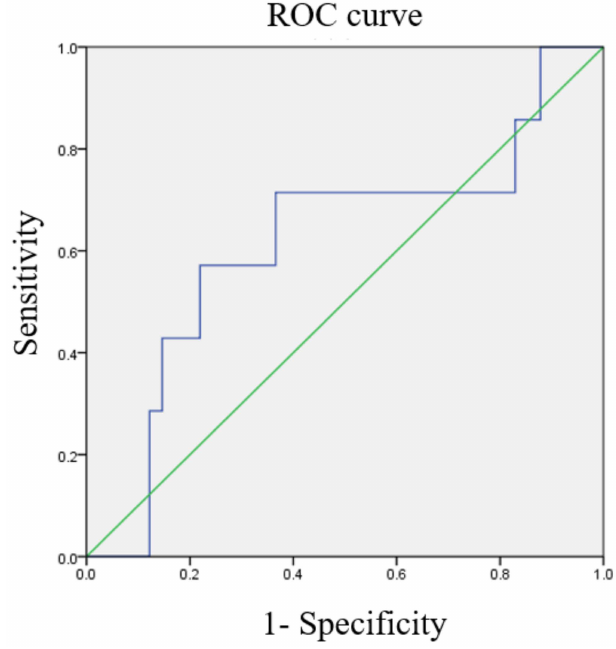
Figure 4. The receiver operating characteristic (ROC) curve of the platelet/lymphocyte ratio predicts cancer death (area under the curve [AUC] = 0.617).